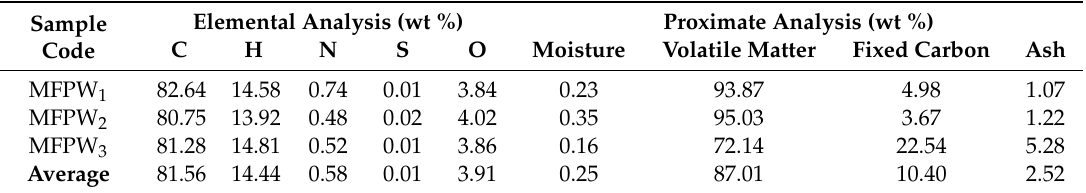
Table 2. Elemental analysis and proximate analysis of all